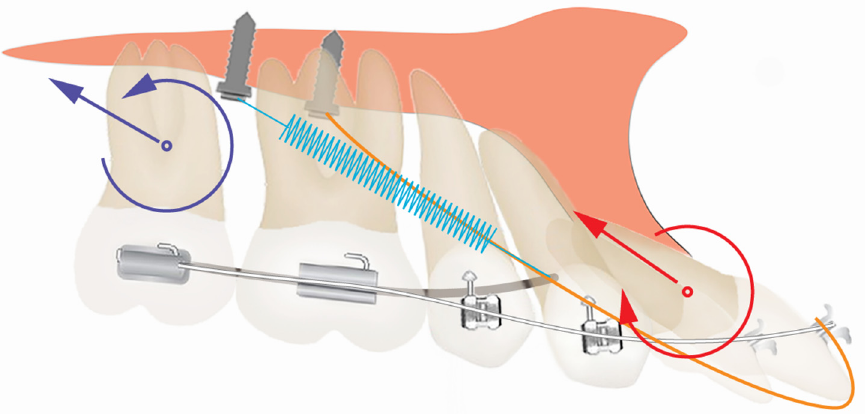
Figure 5. The illustration of the biomechanics for the palatal TADs for molar distalization and the correction of maxillary incisor proclination. The modified TPA (dark grey) was connected to mid-palatal TAD by NiTi coils (blue) for maxillary molar distalization. A distal, intrusion force and a counterclockwise moment were applied to the maxillary second molar (purple arrows). The purple circle represents the center of resistance of the maxillary second molar. The patient was instructed to wear 5/16 3.5 oz elastics (orange) from the lingual buttons on the maxillary central incisors to the mid-palatal TADs. A distal, intrusion force and a clockwise moment were applied to the maxillary central incisor (red arrows). The red circle represents the center of resistance of the maxillary central incisor.